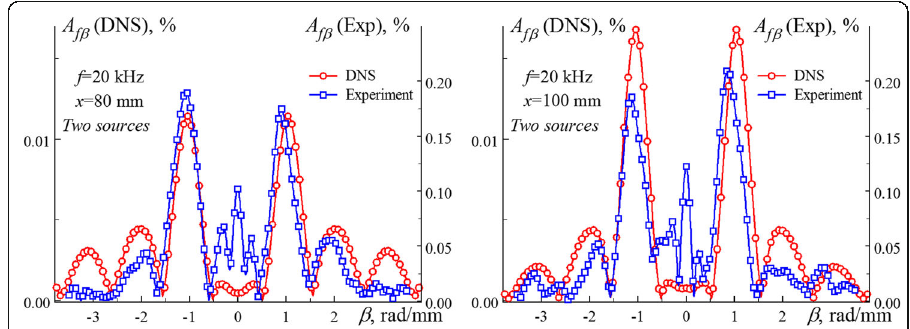
Fig. 10 Amplitude β -spectra of disturbances at f = 20